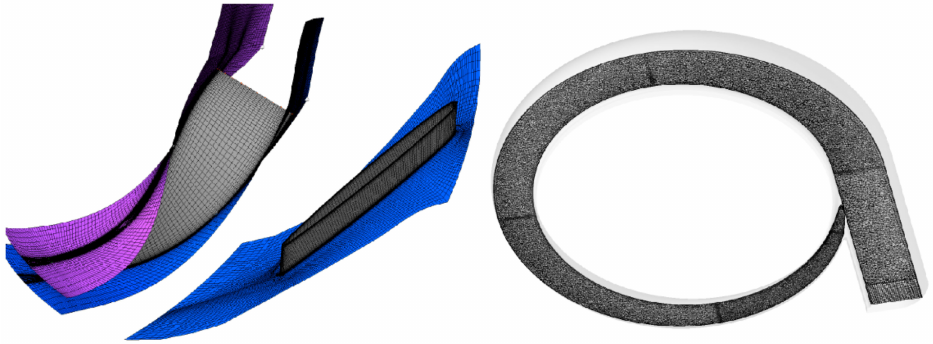
Figure 10. 3D view of the mesh generated for the newly designed